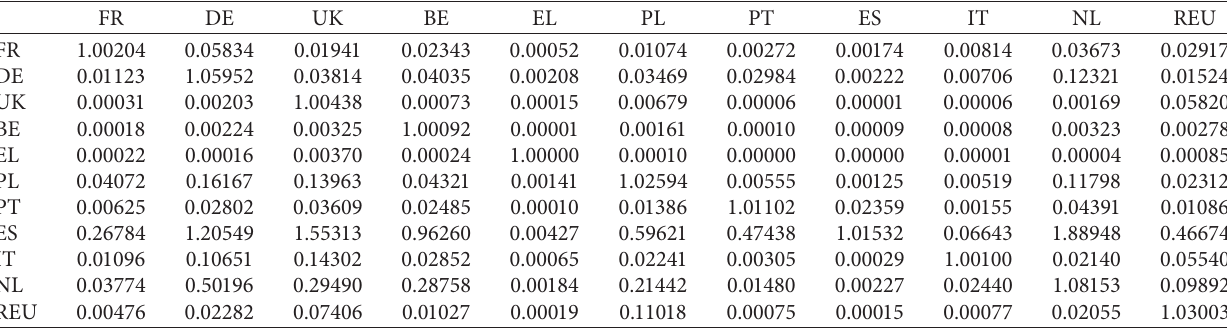
Table 10: Triangulated matrix